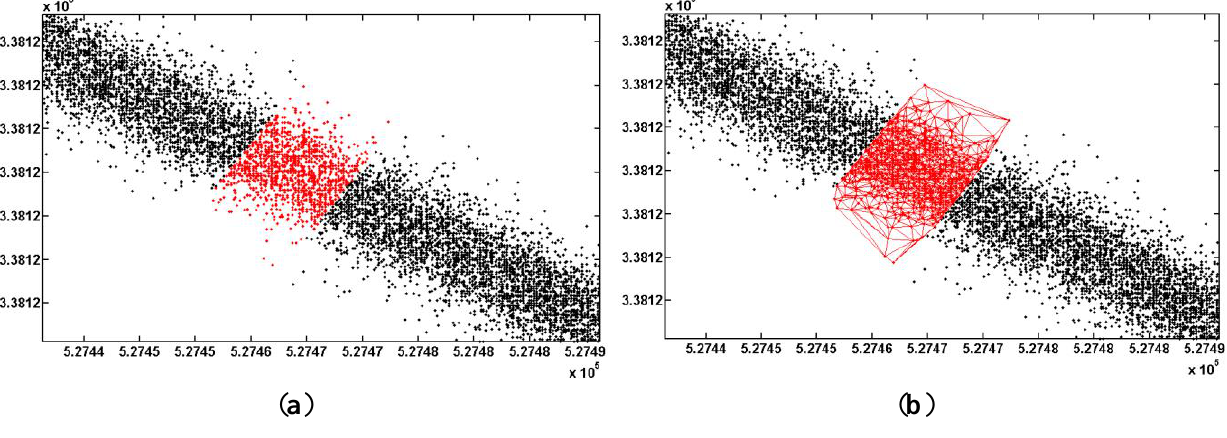
Figure 4. Trajectories optimization way. ( a ) is the tracking points of TS i ; ( b ) shows the Delaunay triangulation network of TSS i